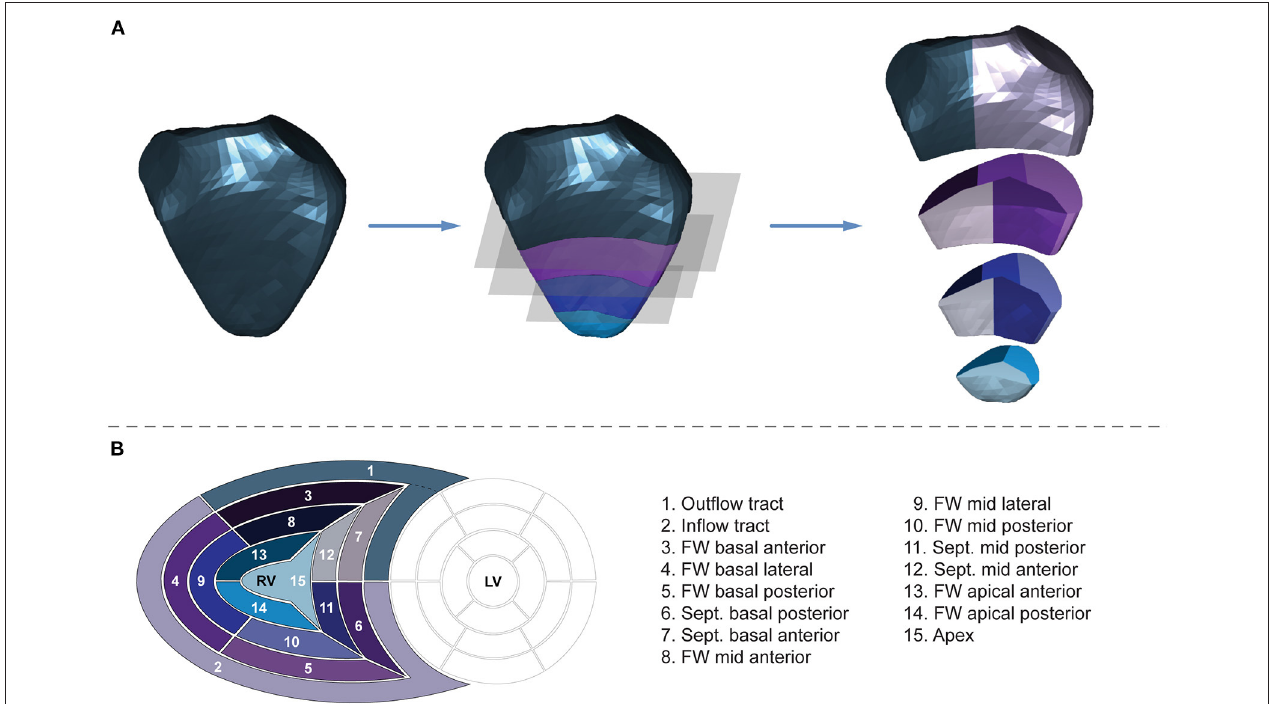
FIGURE 3 | Volumetric partitioning of the right ventricle. (A) Segmentation is performed on the end-diastolic mesh of each series to obtain 15 segments. First, the fraction of the mesh containing the inflow and outflow segments is separated by a horizontal slicing plane positioned at a predefined height along the longitudinal (i.e., vertical) axis. Then, the remainder of the mesh is trisected by two other horizontal planes at equidistant heights. Next, the horizontal slices are divided further. The inflow segment is separated from the outflow segment by a vertical slicing plane along the midpoint of the central vertices of the tricuspid and pulmonary annuli. Using vertically aligned standard planes, the septal and free wall portions of the horizontal slices are divided into further segments. The vertical slicing planes split the slices into three free wall and two septal segments on the basal and mid-levels and into two free wall and one apical segments on the apical level aiming for equal volume distribution among the segments within the given slice. See text for further details. The 3D right ventricular model is visualized from septal point of view. (B) The “bull’s eye” plot and the nomenclature of the 15 newly generated right ventricular segments. FW, free wall; LV, left ventricle; RV, right ventricle; Sept.,